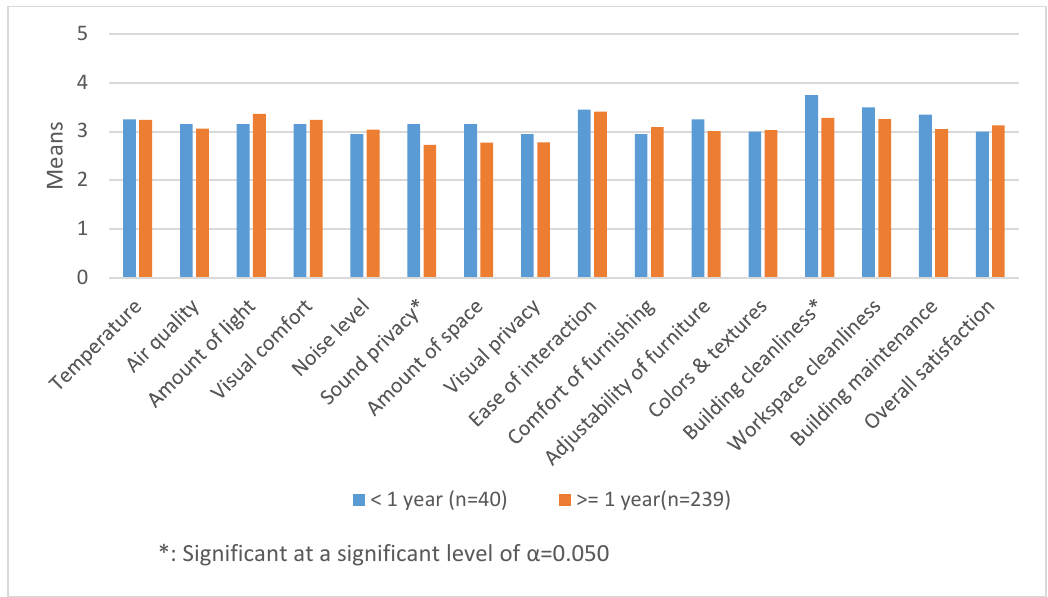
Figure 6 . The impact of duration at the current workstation on satisfaction with IEQ factors. Figure 6. The impact of duration at the current workstation on satisfaction with IEQ